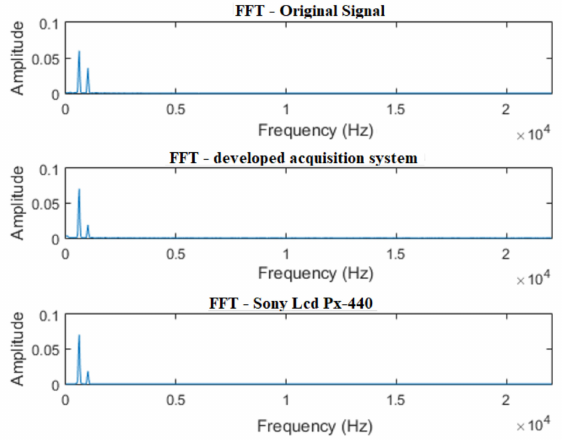
Figure 17. FFT of a two-tone signal: F1 = 600 Hz/F2 = 1000